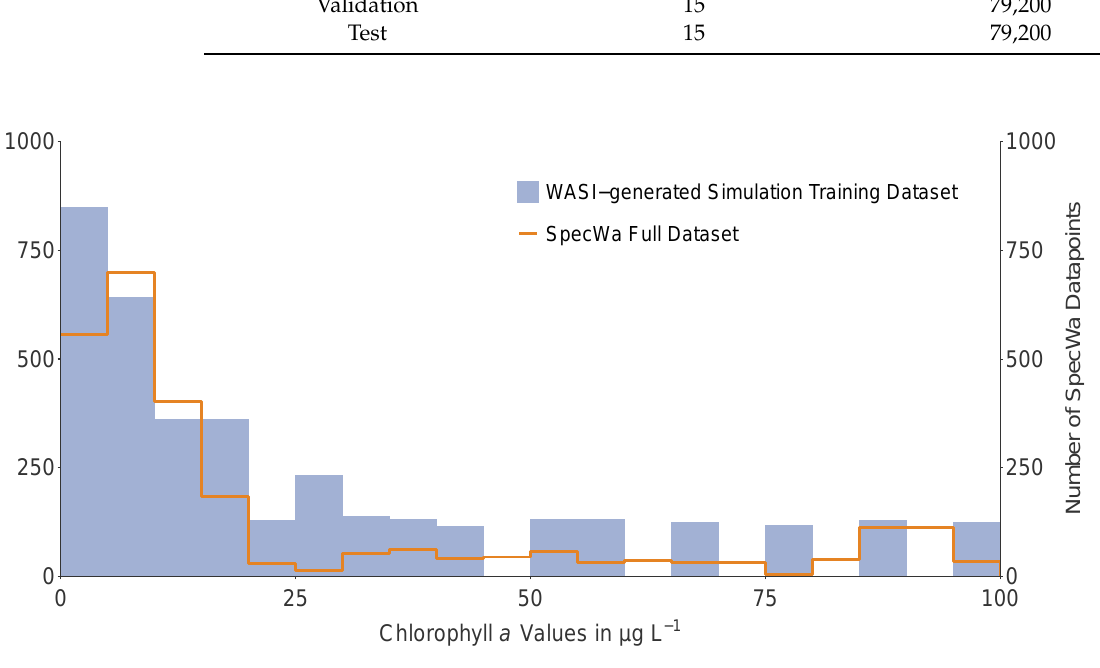
Figure 6. Distributions of of the chlorophyll a values between the WASI training subset and the SpecWA dataset. The WASI training set refers to the left y-axis and has about 100 times more datapoints than the SpecWa dataset which is referred to the right